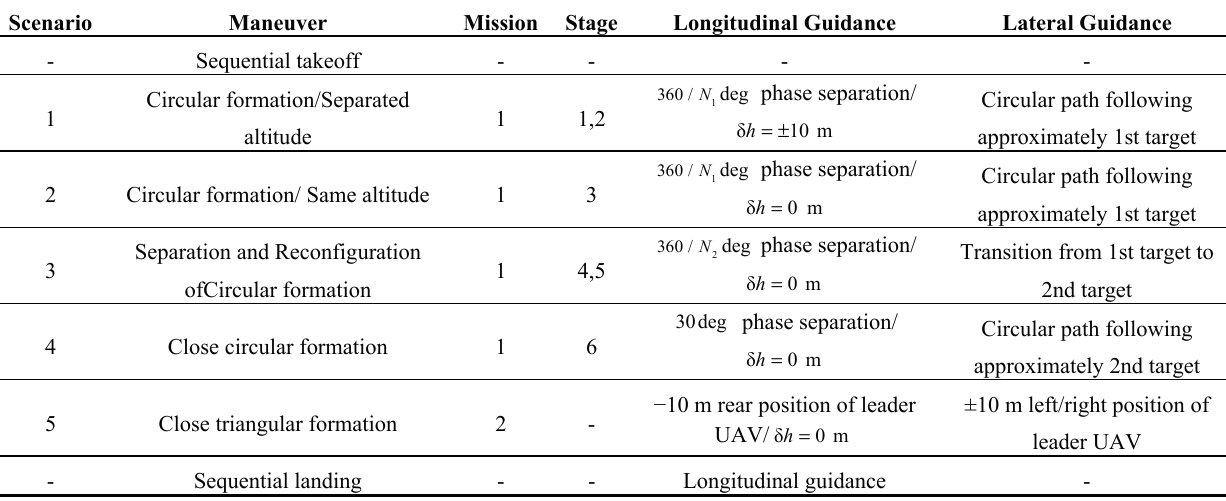
Table 4. Integrated formation flight